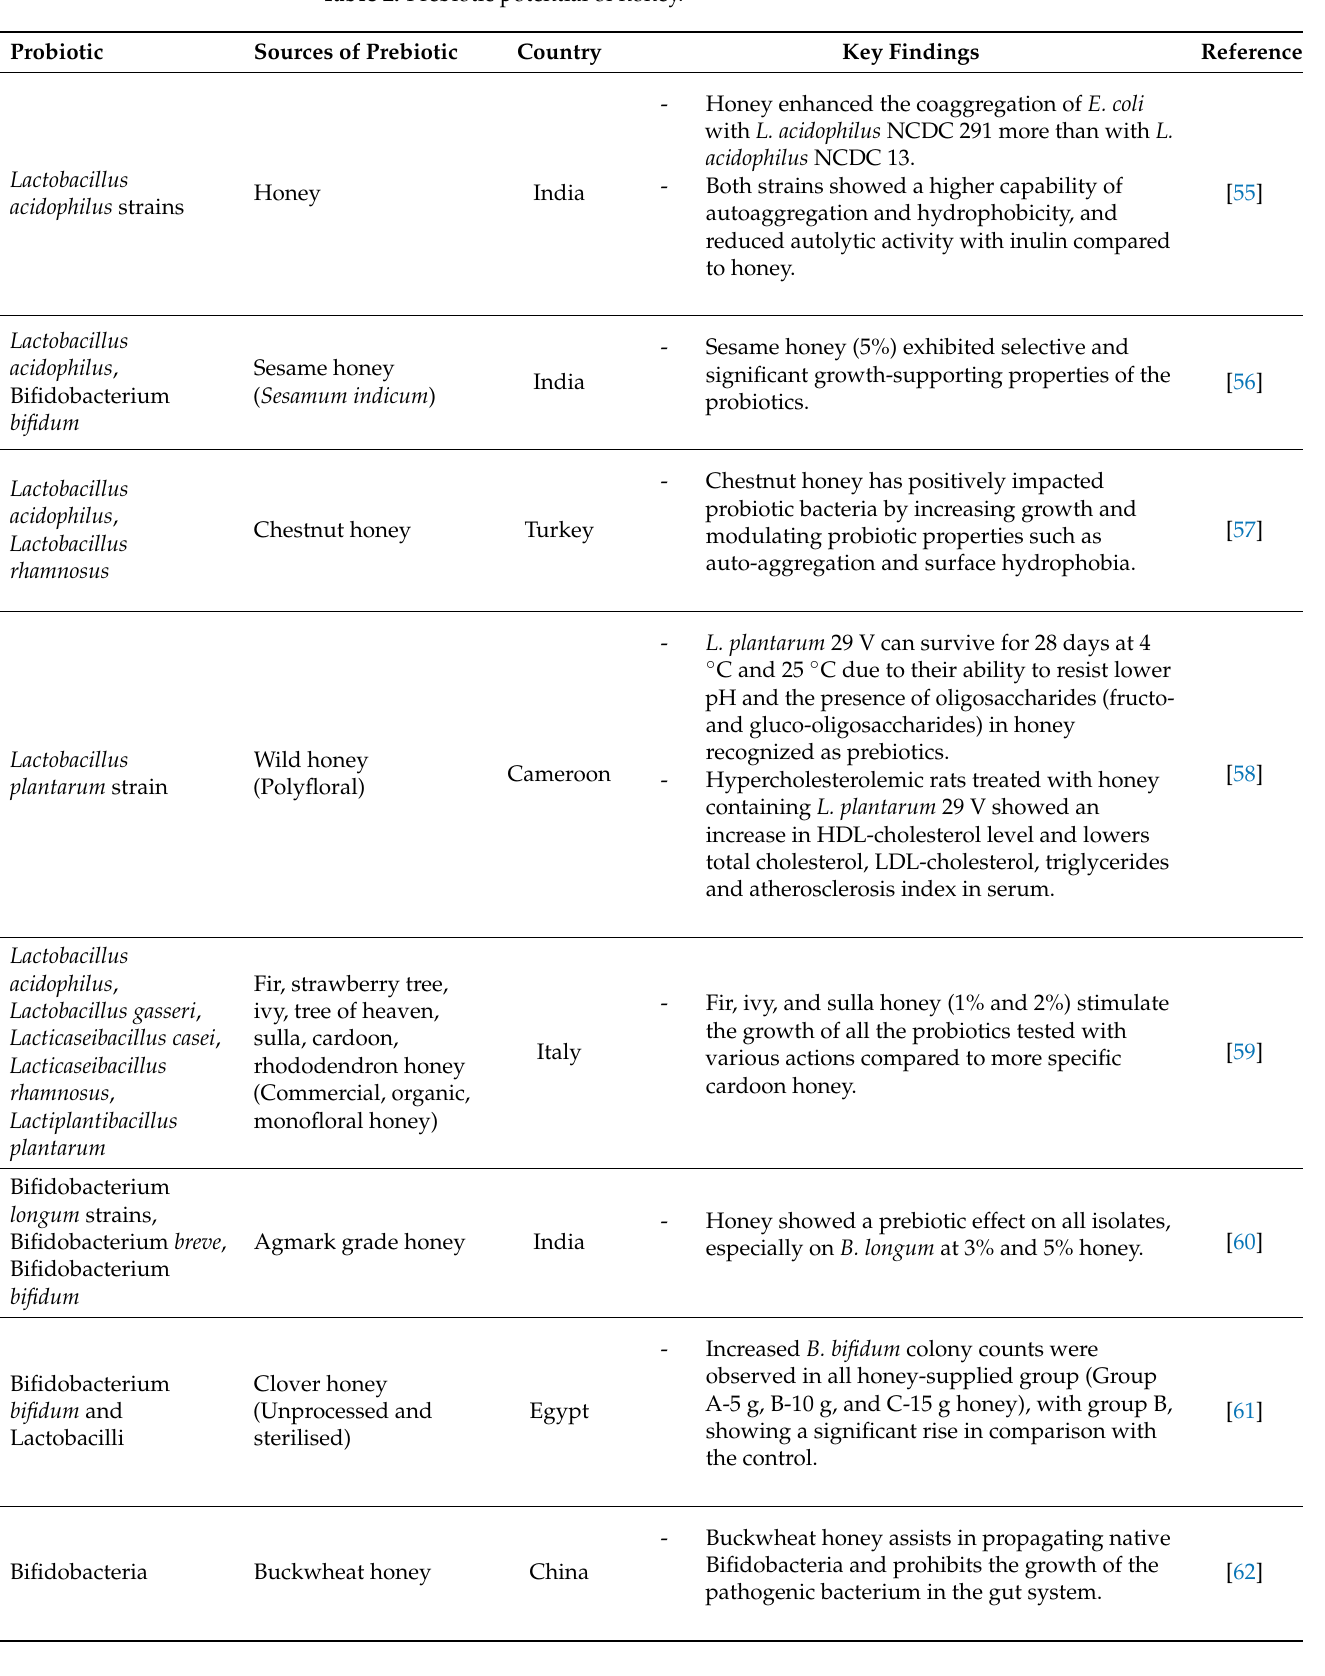
Table 2. Prebiotic potential of